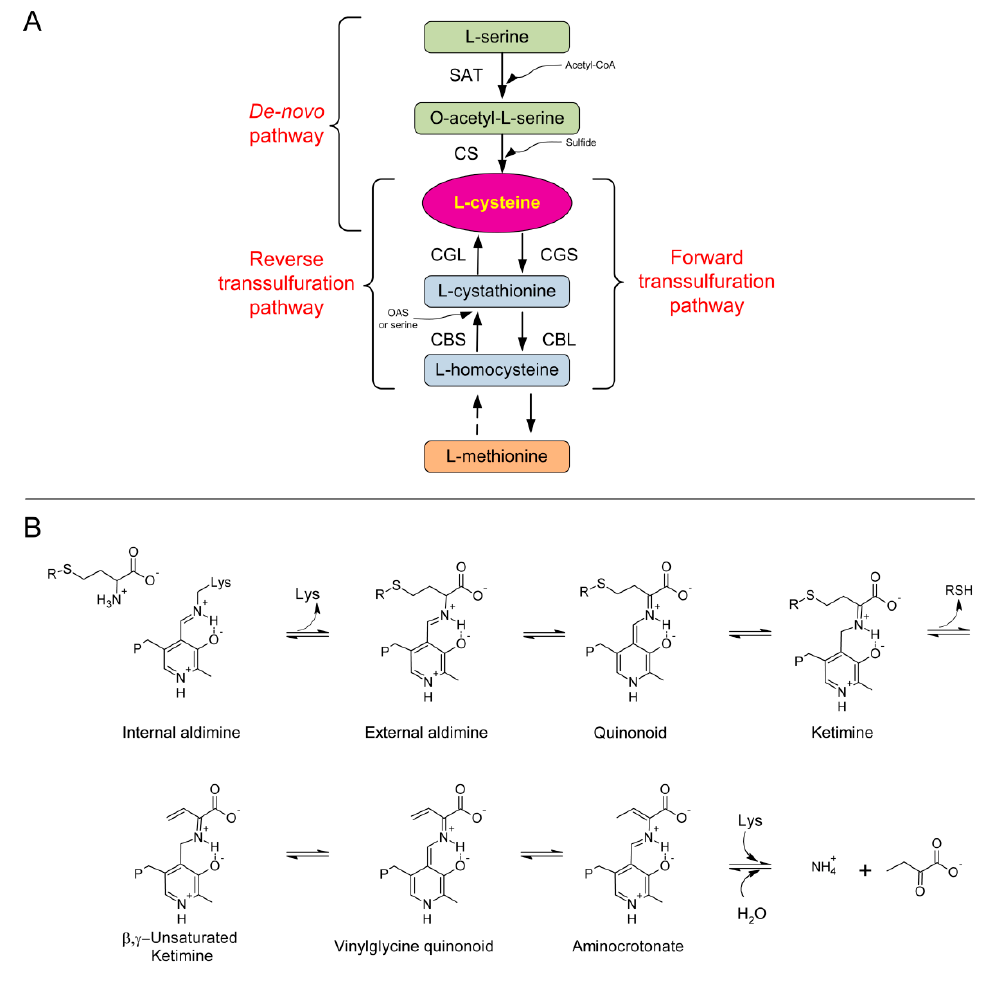
Figure 1. Overview of cysteine metabolism and of reaction catalyzed by CGL. ( A ) Cysteine production via a de novo pathway involving serine acetyltransferase (SAT) and cysteine synthase (CS) from serine in the presence of reduced sulfur. Forward transsulfuration pathway involving cystathionine γ -synthase (CGS) and cystathionine β -lyase (CBL) using the substrate L -cysteine to produce L -homocysteine via the intermediate L -cystathionine. Reverse transsulfuration pathway including cystathionine β -synthase (CBS) and cystathionine γ -lyase (CGL) using the substrate homocysteine in the presence of serine or OAS with an intermediate cystathionine. Dashed arrow implicates several enzymatic reaction steps which were omitted for clarity. ( B ) Mechanism of the γ -elimination reaction in CGL. The substrate is cystathionine and R = CH 2 CH(NH 3+ )COO − .